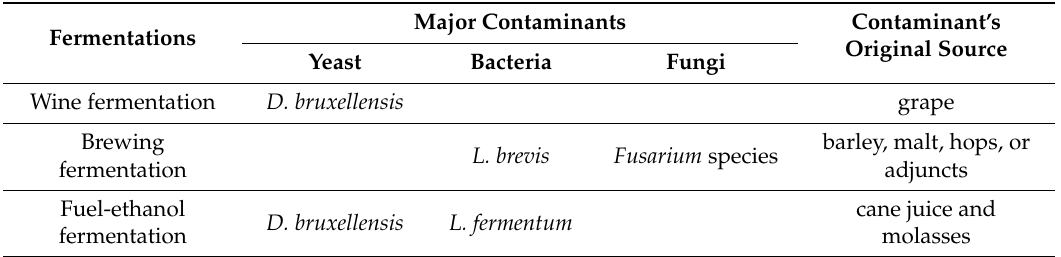
Table 1. List of major contaminants in wine, brewing, and fuel ethanol fermentation